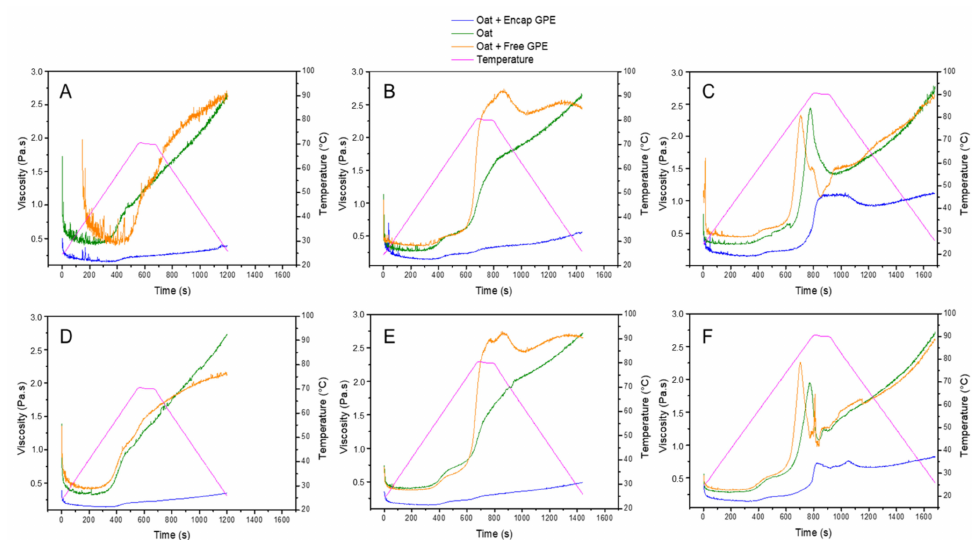
Figure 4. DHR-3 pasting curves of oatmeal paste enriched with encapsulated GPE and free GPE. Testing conditions: ( A ) temperature 70 ◦ C and shear rate 50 1/s; ( B ) temperature 80 ◦ C and shear rate 50 1/s, ( C ) temperature 90 ◦ C and shear rate 50 1/s; ( D ) temperature 70 ◦ C and shear rate 100 1/s; ( E ) temperature 80 ◦ C and shear rate 100 1/s; ( F ) temperature 90 ◦ C and shear rate 100